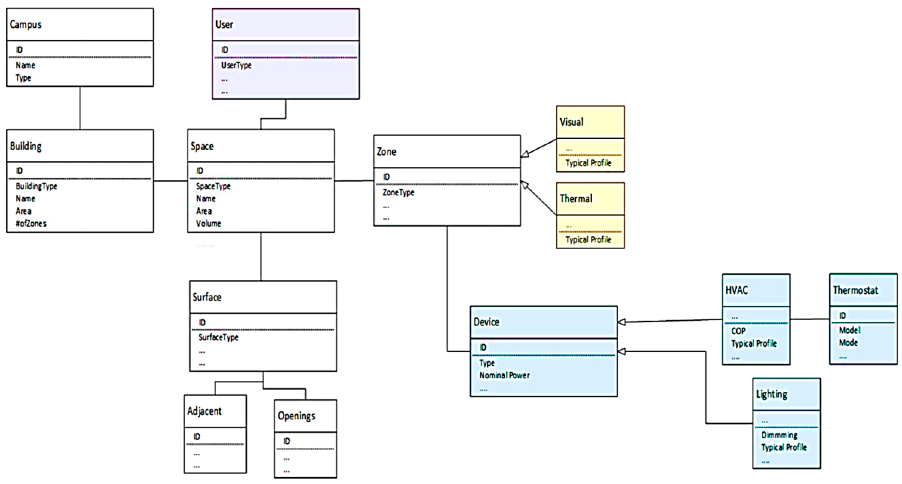
Figure 2. Entity–Relationship model.